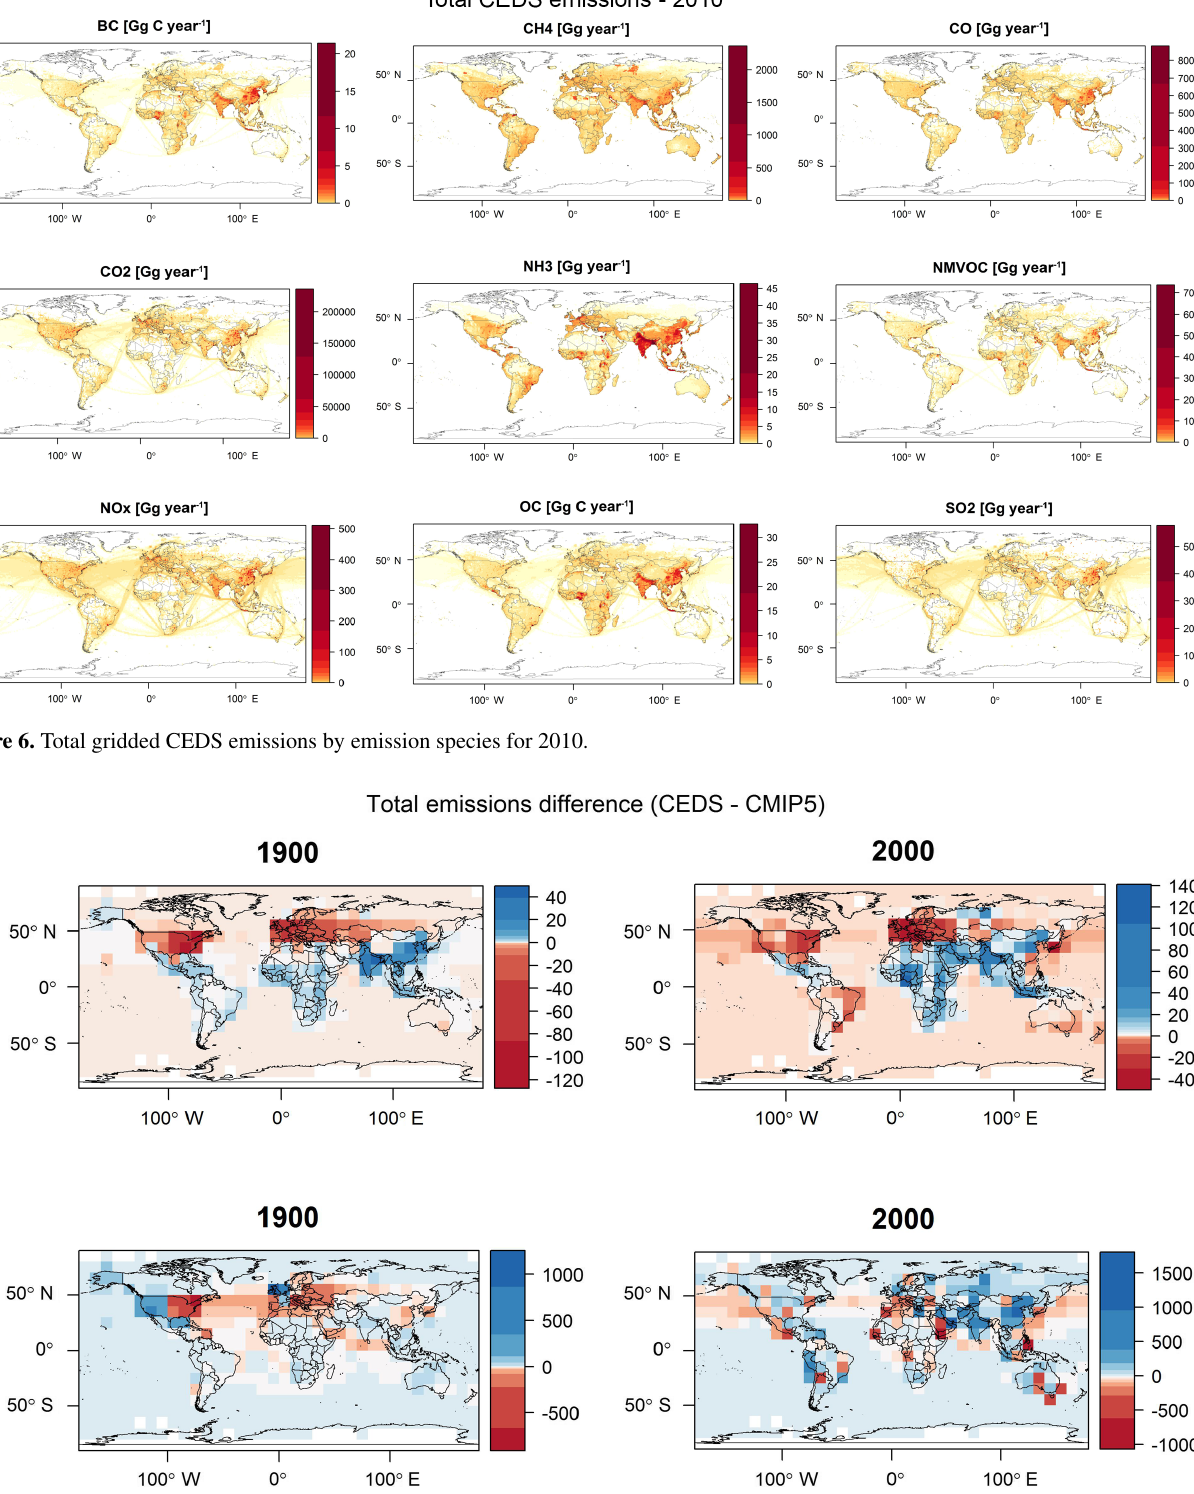
Figure 7. Difference between CEDS and CMIP5 total gridded emissions for BC (top) and SO 2 (bottom) in 1900 (left) and 2000 (right) at 10 ◦ grid cells. Values shown are CEDS – CMIP5 estimates. For like-with-like comparison, these figures do not include aviation or agricultural waste burning on